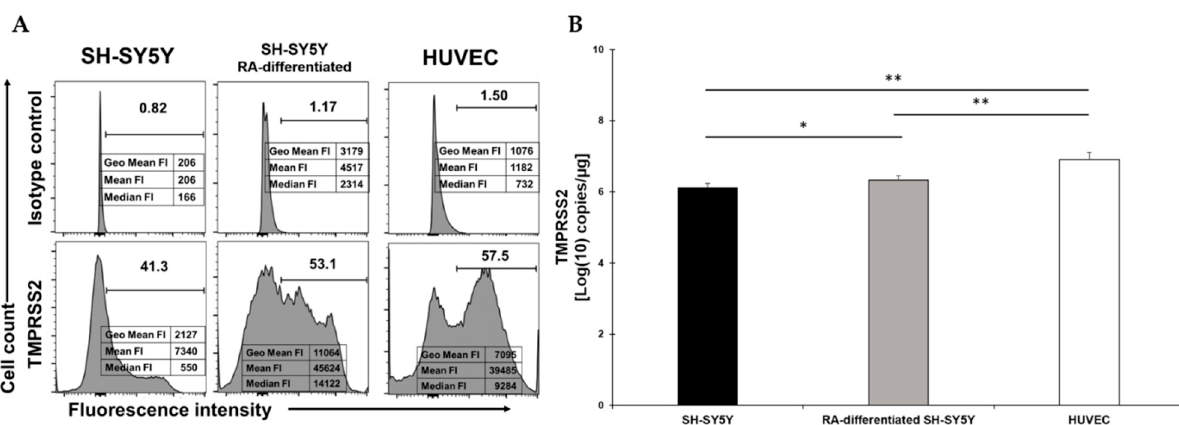
Figure 2. ( A ) Flow cytometry analysis of TMPRSS2 expression in SH-SY5Y (left), RA-differentiated SH-SY5Y (middle), and HUVEC (right) cells. Both SH-SY5Y and HUVEC cells were stained with the specific antibody for the receptor (bottom) or the corresponding isotype control (top). The data related to the fluorescent intensity are also indicated in the figure. A representative of three different experiments is shown. ( B ) mRNA expression levels of TMPRSS2 in both SH-SY5Y and RA-differentiated SH-SY5Y and HUVEC cells. Experiments were done in duplicates. Copy number per µg of mRNA is indicated. * p < 0.05 and ** p < 0.01.